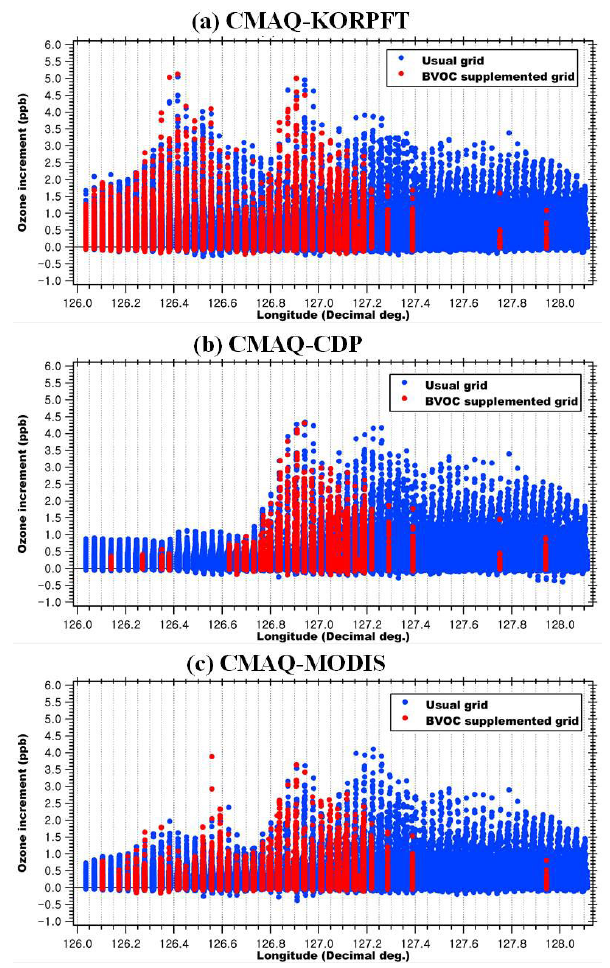
Figure 6. Longitudinal distribution of the incremented ozone con- centrations due to the effect of additional BVOC emissions for each PFT scenario via LAIv input supplementation for MEGAN model- ing. A filled red circle denotes an O 3 increment in an LAIv supple- mented grid cell. A filled blue circle indicates an O 3 increment in a normal grid